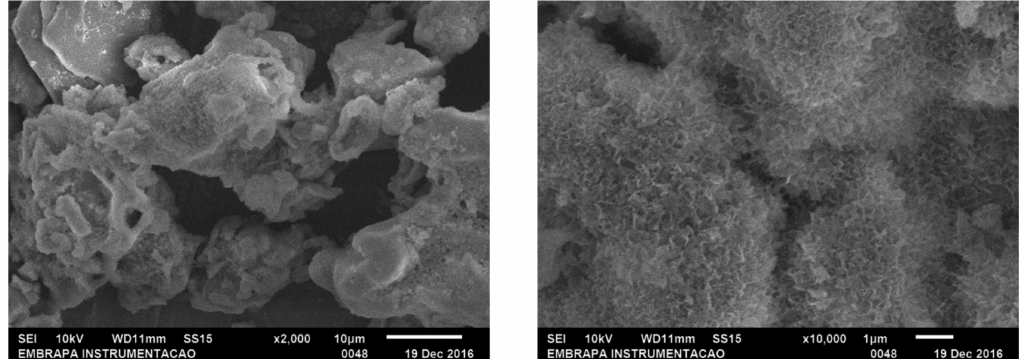
Figure A1. SEM images of Aspergillus niger glucose-oxidase and bovine liver catalase in combi-CLEAs co-precipitated with BSA.